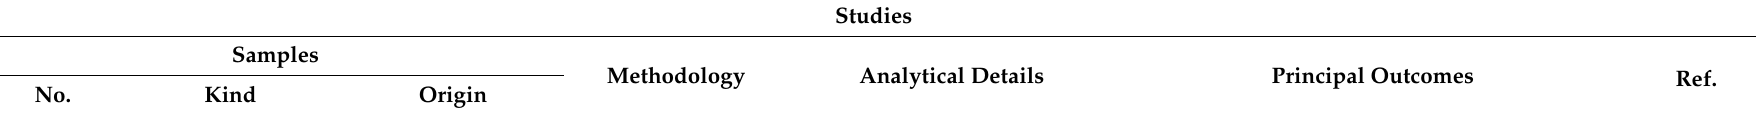
Table 1. Physico-chemical, microbiological, and antioxidant characteristics of coconut sap, sugar, and